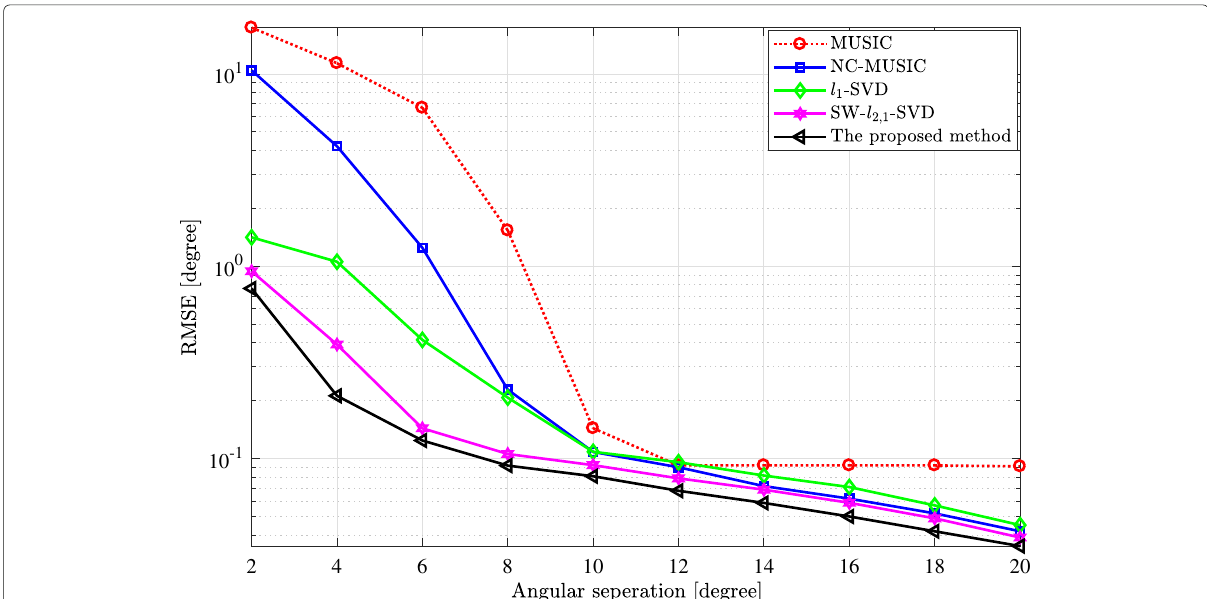
Fig. 5 RMSEs of MUSIC, NC-MUSIC, l 1 − SVD, SW − l 2,1 − SVD, and the proposed method as a function of the angular separation between two source for SNR = 0 dB and N =